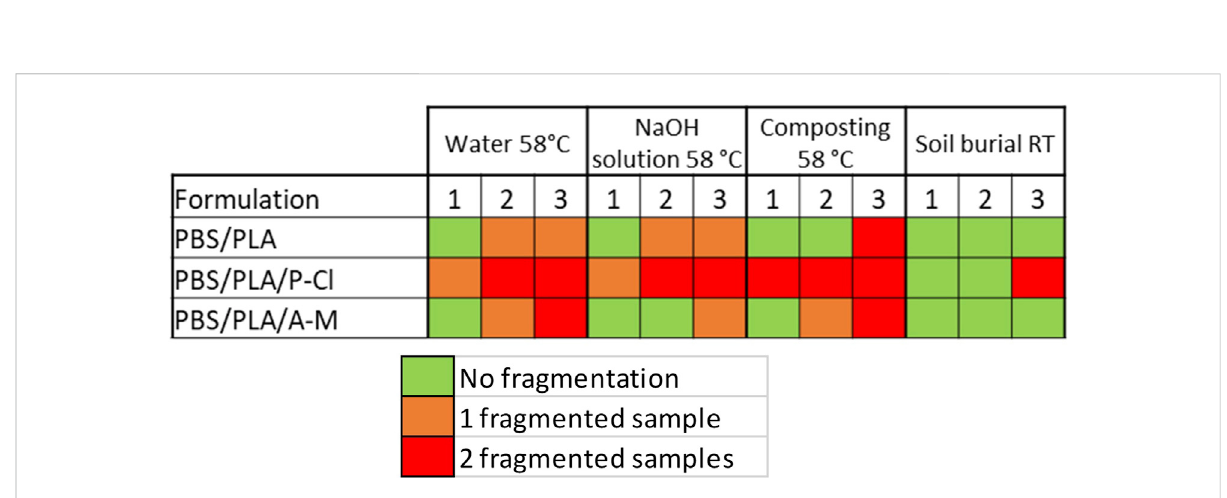
FIGURE 5 Fragmentation observed during ageing experiment, in